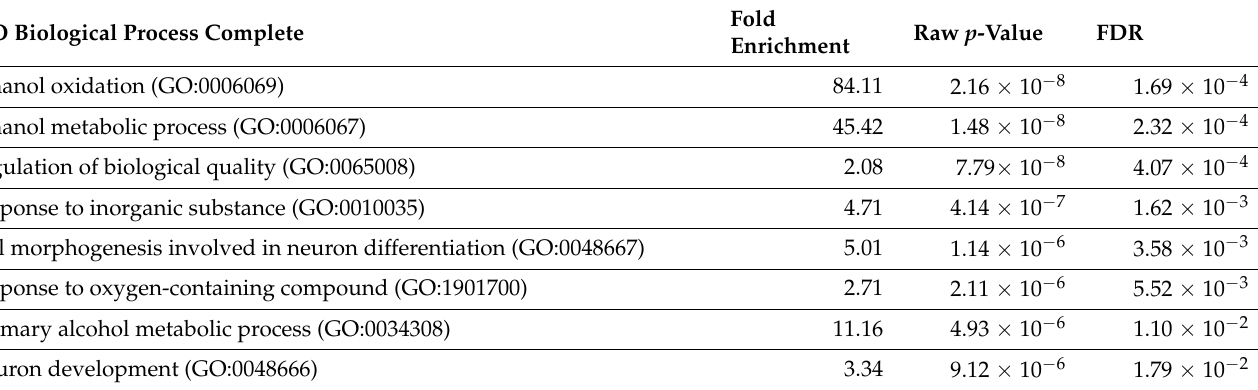
Table 5. Gene Ontology enrichment analysis of biological processes, associated with the 135 genes in the